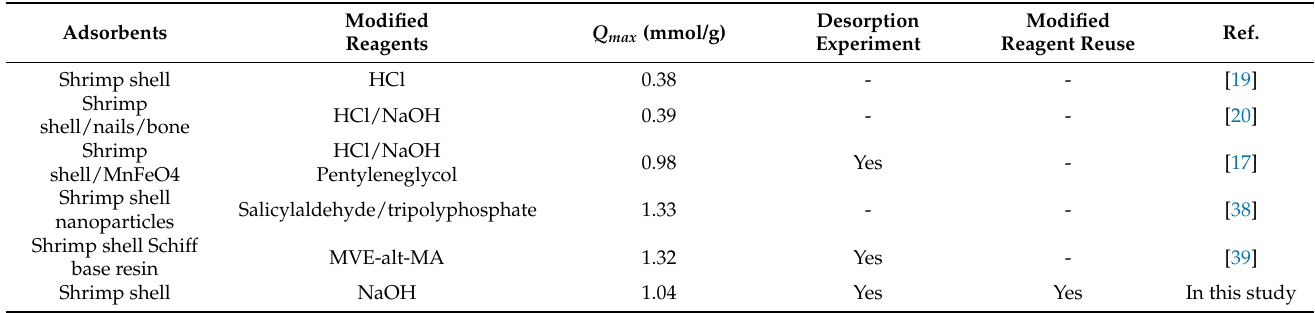
Table 5. Comparison of adsorption capacity of Cu (II) by different